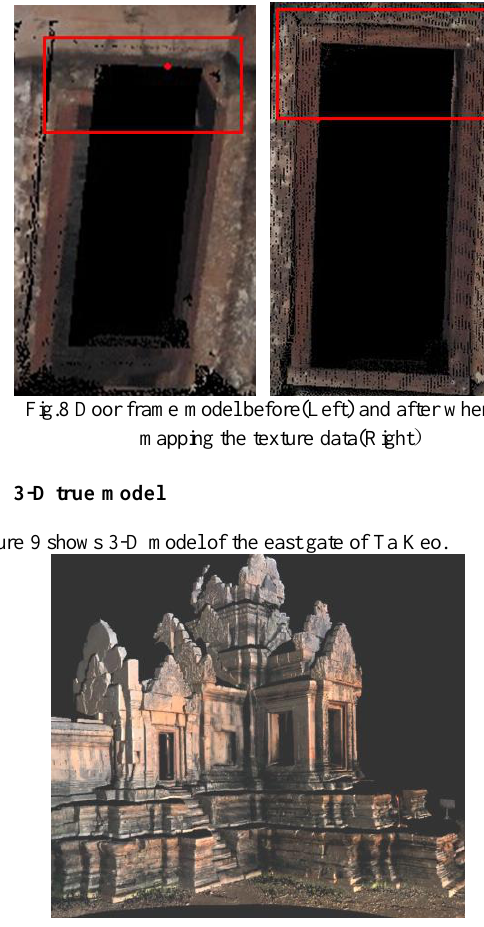
Fig.9 3-D model of the east gate of the Ta Keo